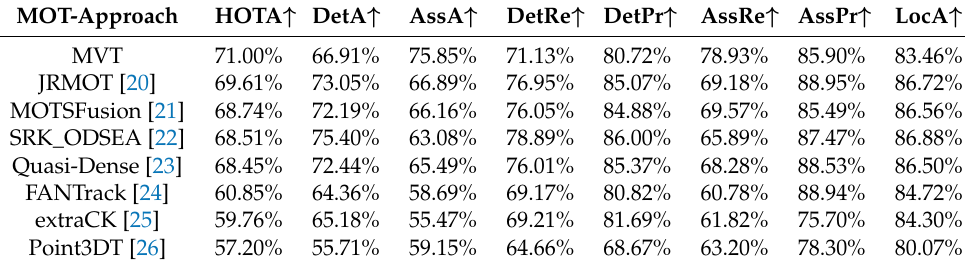
Table 1. Comparison results of several algorithms for eight metrics such as HOTA.